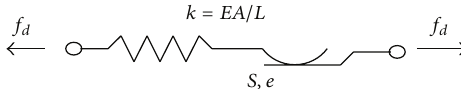
Figure 4: Mechanical model of friction